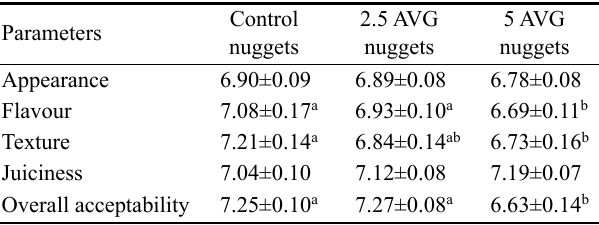
Table 4. Effect of Aloe vera gel addition on the sensory characteristics of goat meat nuggets